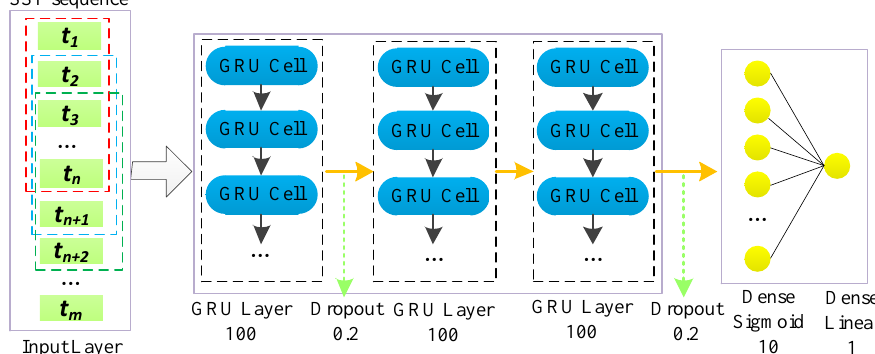
Figure 3. Model structure used in this study for medium and long-term SST prediction.